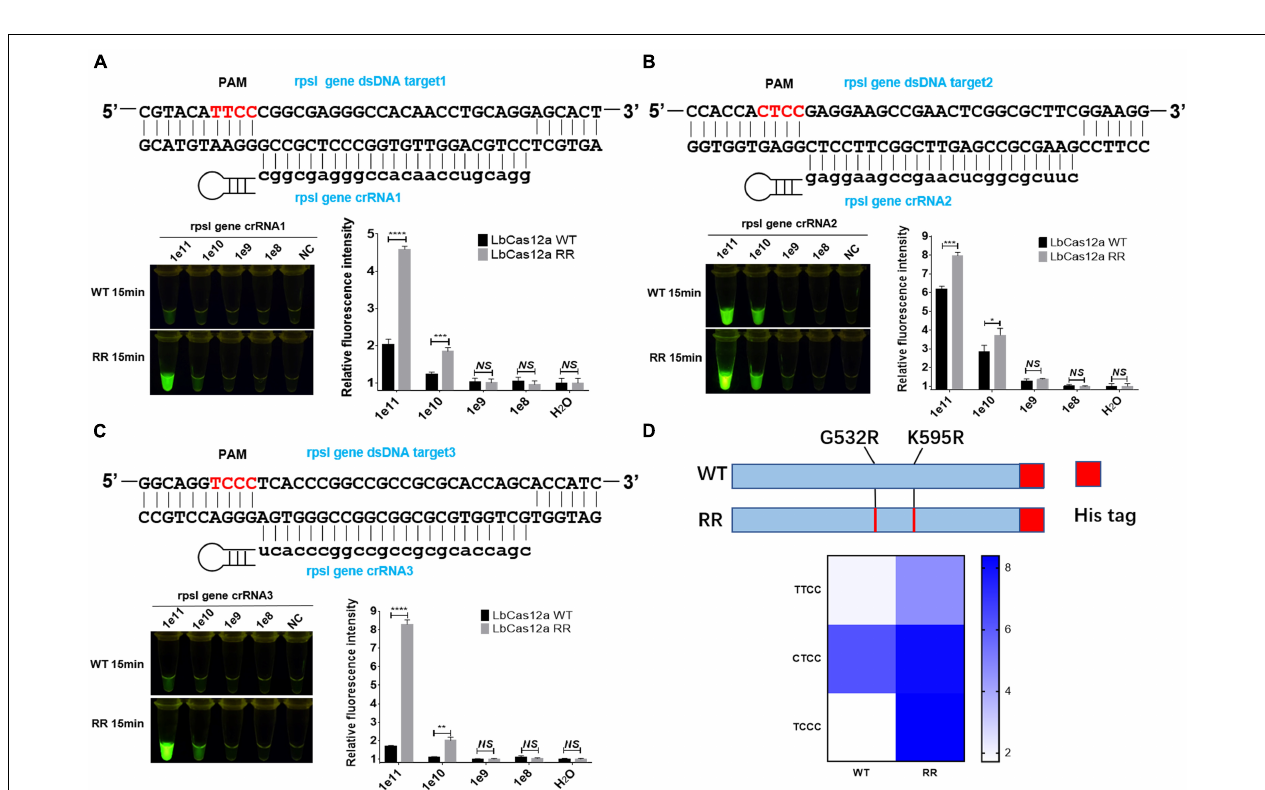
FIGURE 2 | Functional verification of the Cas12a RR protein. The Cas12a RR protein recognizes the TTCC (A) , CTCC (B) , and TCCC (C) targeting sequences. The fluorescent images and fluorescence intensity (A–C) at 15 min of the reaction are shown. (D) Cas12a RR protein recognizes TTCC, CTCC, and TCCC target sequence heat map. Data are presented as the mean ± SEM from at least three independent experiments. * p < 0.05, ** p < 0.01, *** p < 0.001, and **** p < 0.0001.